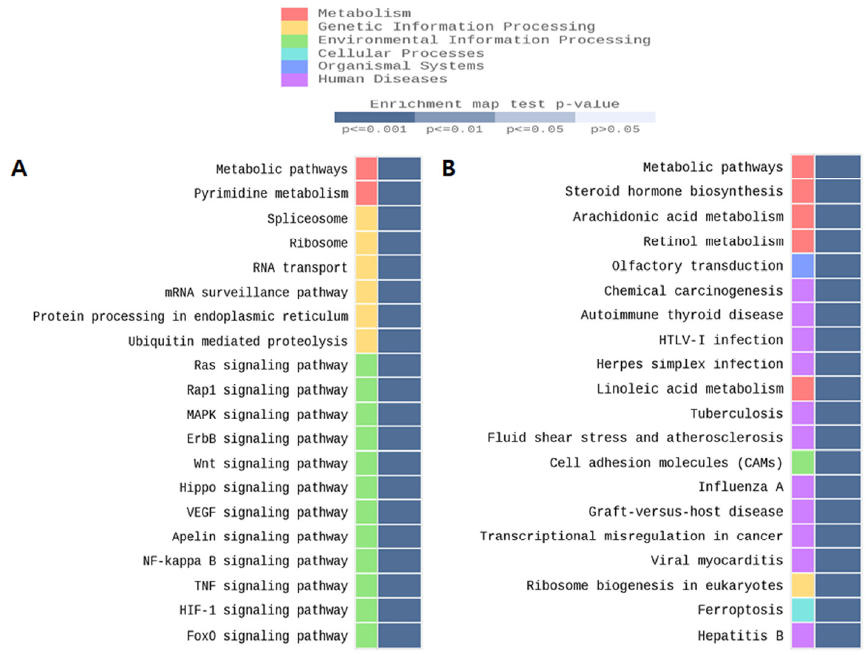
Figure 2. Top-ranked gene enrichment networks from querying the KEGG database with MBD-seq data from prenatal TMT exposed male hippocampus. ( A ) CGI promoter region. ( B ) Non-CGI pro- moter region.